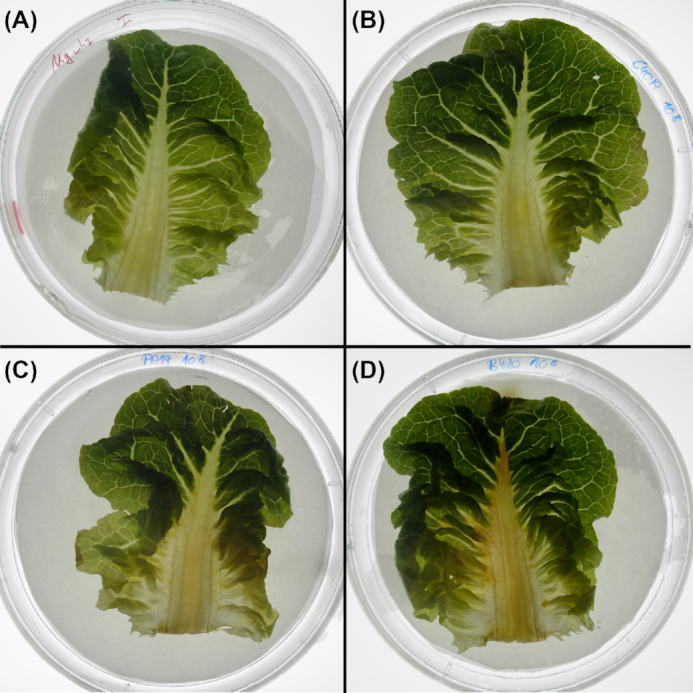
Different degree of virulence in a salad leaf infection model. The examples display the different virulence of P. aeruginosa strains in a salad (Lactuca sativa var. longifolia) infection assay. MgCl2 solution containing 108 CFU of bacteria was instilled into the midrib of the lettuce leaf. Progress of infection was represented by the spread of a brownish rotten area to the different parts of the salad leafs. The panels show the spread of the infection 44 h after instillation of MgCl2 solution (negative control, panel A), clone C/C40A (panel B), clone PA14 (panel C) and B420 (panel D). The respective leaf appeared rather unaffected after instillation of clones C and PA14. Clone B420, however, which displayed very low virulence in the mouse infection model, caused a much more severe phenotype in this assay with rotting visible in wide areas of the lettuce leaf.